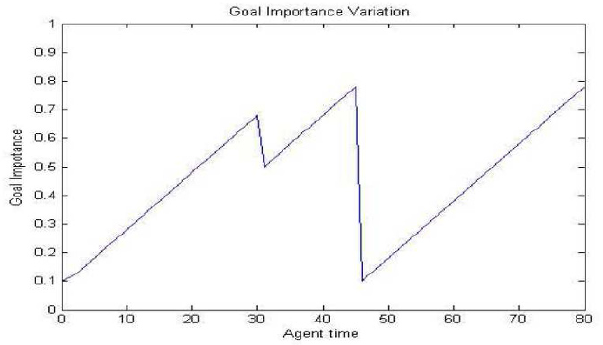
Figure 6. Goal importance value fluctuation over an